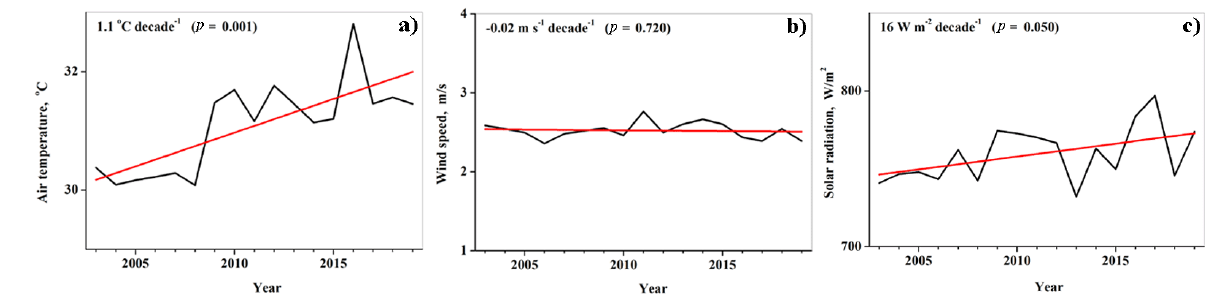
Figure 9. Year-to-year variations of ( a ) air temperature, ( b ) wind speed, and ( c ) surface solar radiation measured at the Zemah meteorological station, between 9 LT and 10 LT, in summer (June–August), during the 17-year study period. The straight red lines designate linear